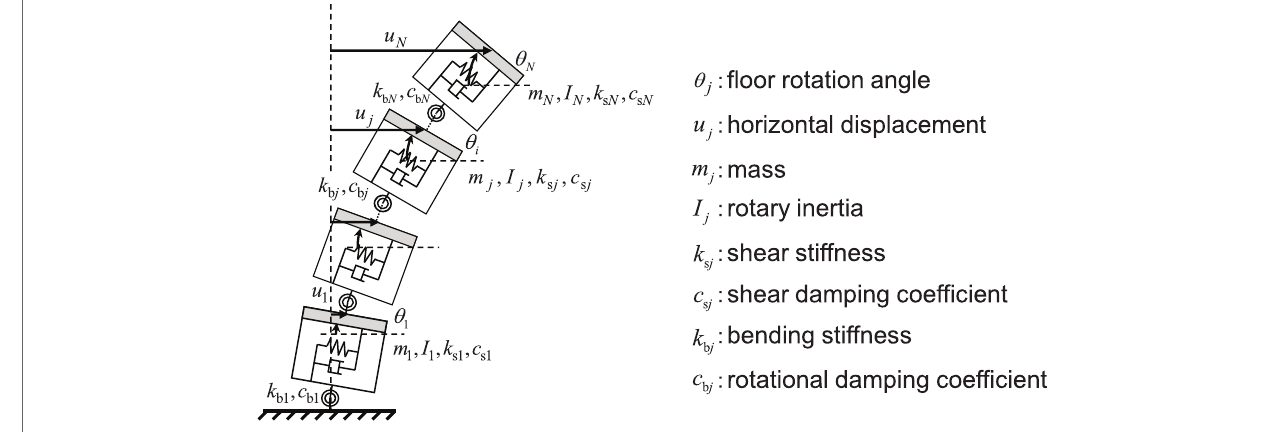
FIGURE 1 | Shear-bending